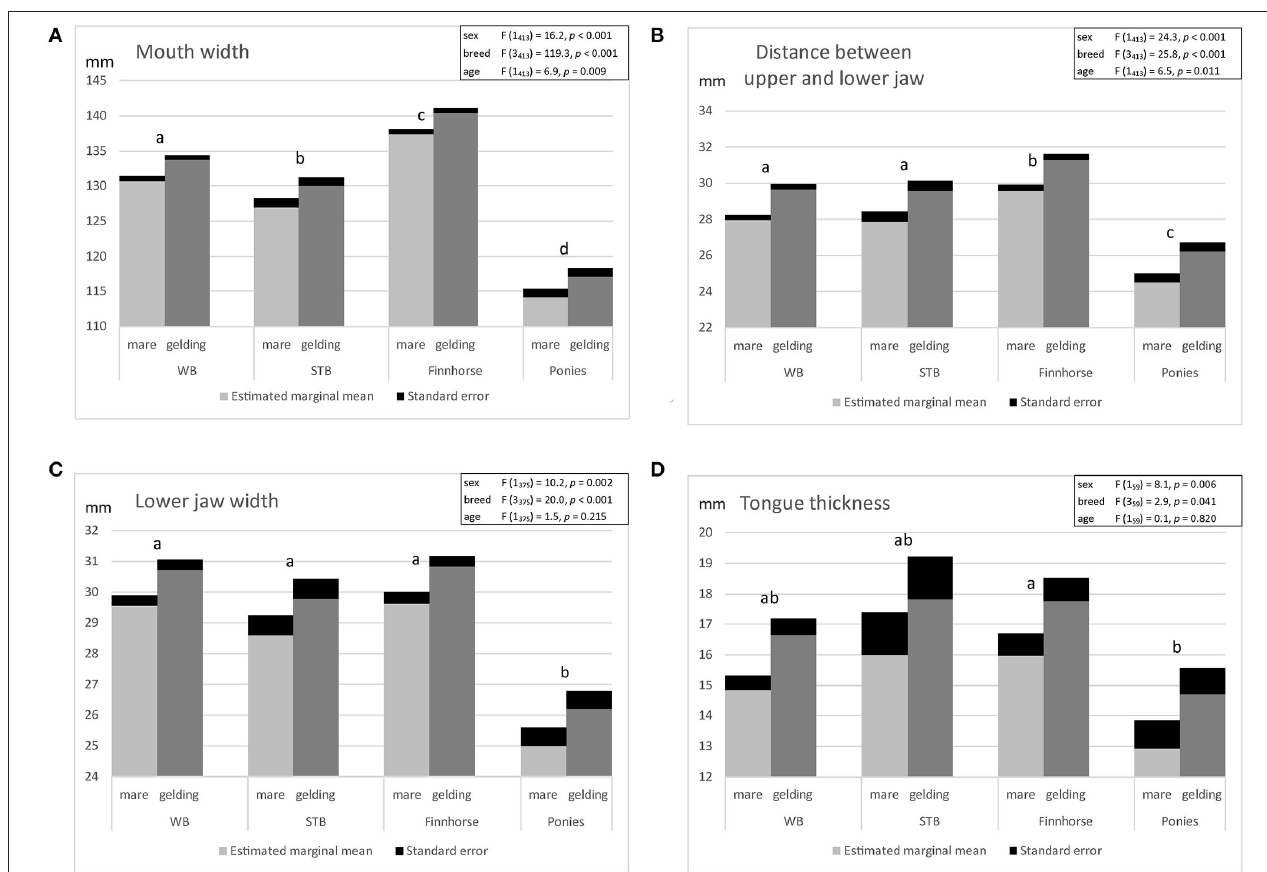
FIGURE 3 | Estimated marginal means of linear regression model of oral dimensions in mares and geldings of different breeds [Warmblood (WB), Standardbred (STB), Finnhorse, ponies] of adult horses and ponies ≥ 5 years: (A) mouth width, (B) distance between upper and lower jaw, (C) lower jaw width, (D) tongue thickness (significant differences between breeds marked by differing